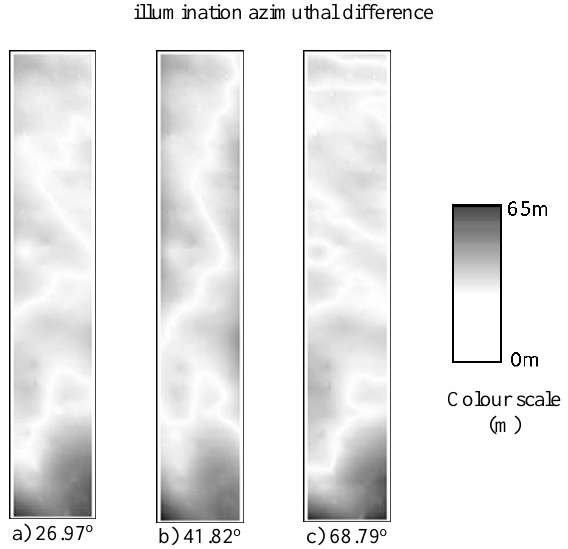
Figure 6. 3D view of SAfS DEMs (1m/pixel) at each